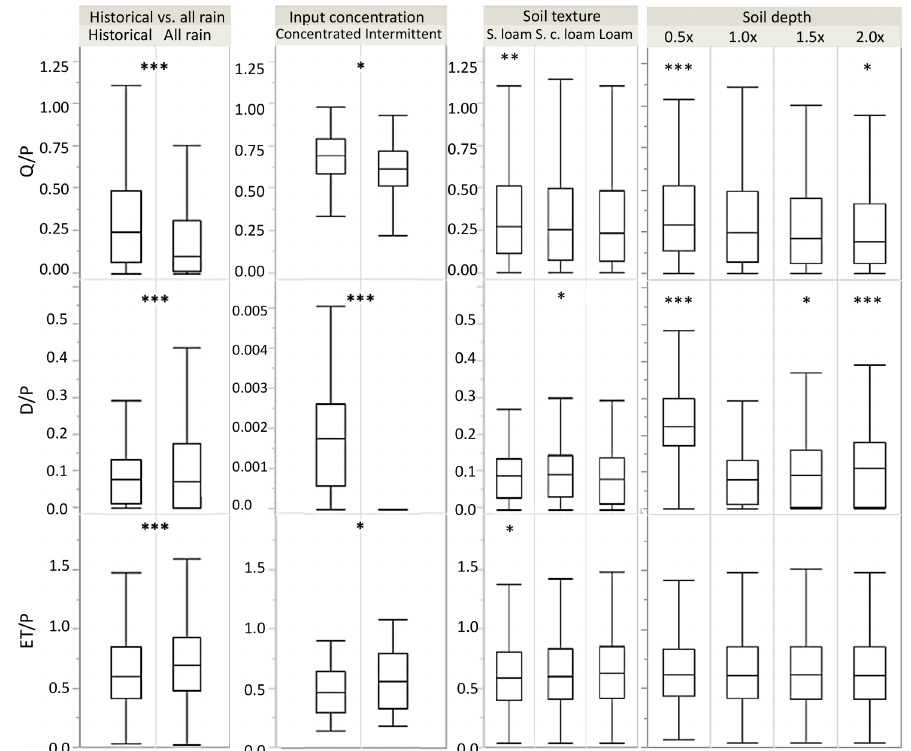
Figure 6. Boxplots of Q/P , D/P , and ET /P for four different experiments: historical vs. all rain input on loam soil and constant 1 × depth, intermittent vs. concentrated input on loam soil and constant 1 × depth, different soil textures with constant 1 × depth, and different soil depths all with loam soil texture. Asterisks denote significance of ANOVA tests between groupings. P value of ANOVA, ∗ < 0 . 05, ∗∗ < 0 . 01, and ∗∗∗ < 0 . 001. Boxplots correspond to values in Table 3. Soil texture and soil depth scenarios are compared to 1 × depth and loam texture profile for ANOVAs.